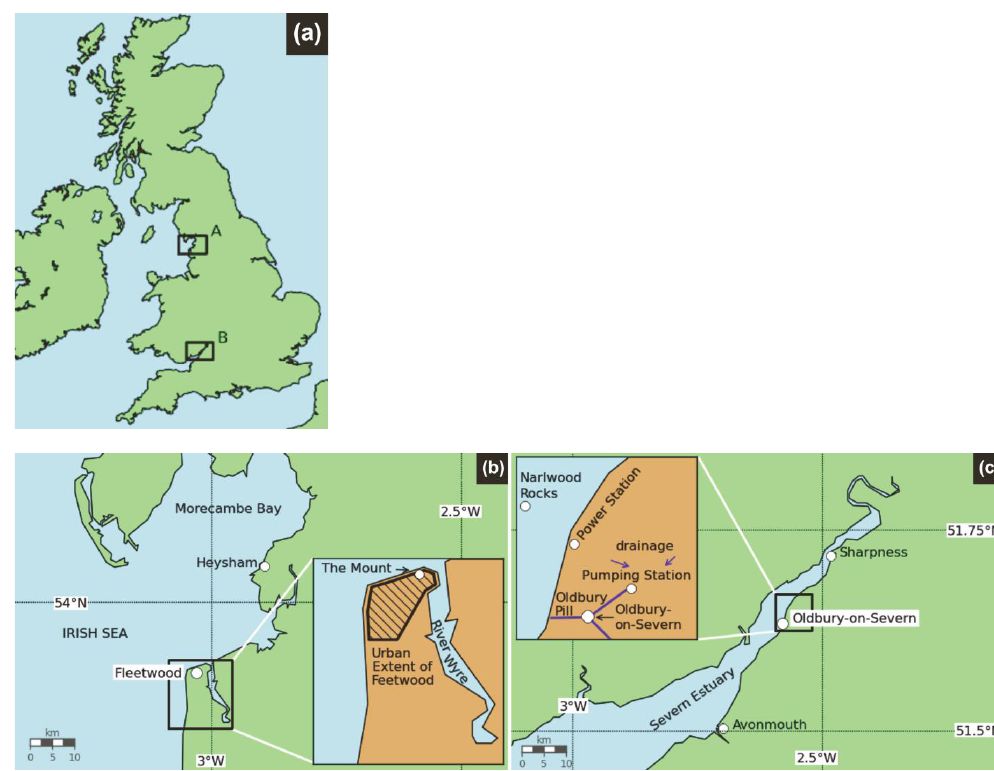
Figure 1. (a) UK map showing the locations of the two case studies: (A) strategic case study centred upon Fleetwood, (B) operational case study centred upon Oldbury-on-Severn. (b) Map showing location of strategic case study centred upon Fleetwood; urban extent of Fleetwood and The Mount. (c) Map showing location of operational case study centred upon Oldbury-on-Severn; Oldbury Pill, pumping station and nuclear power